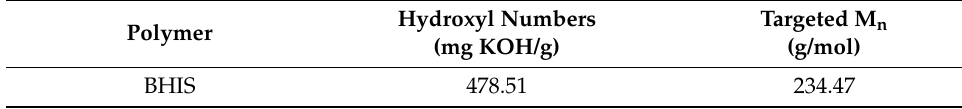
Figure 3. 1 H-NMR analysis of synthesized BHIS. Table 2. Hydroxyl numbers and molecular weight of